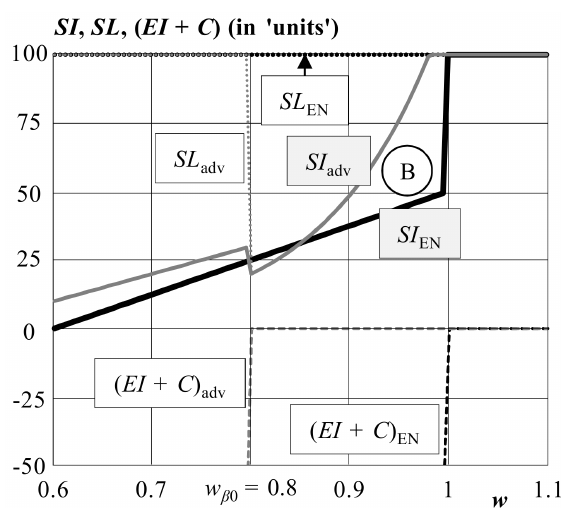
Figure 3. Variation of sustainability indicator SI , benefit SL , and loss C with ratio w (neglected EI ).